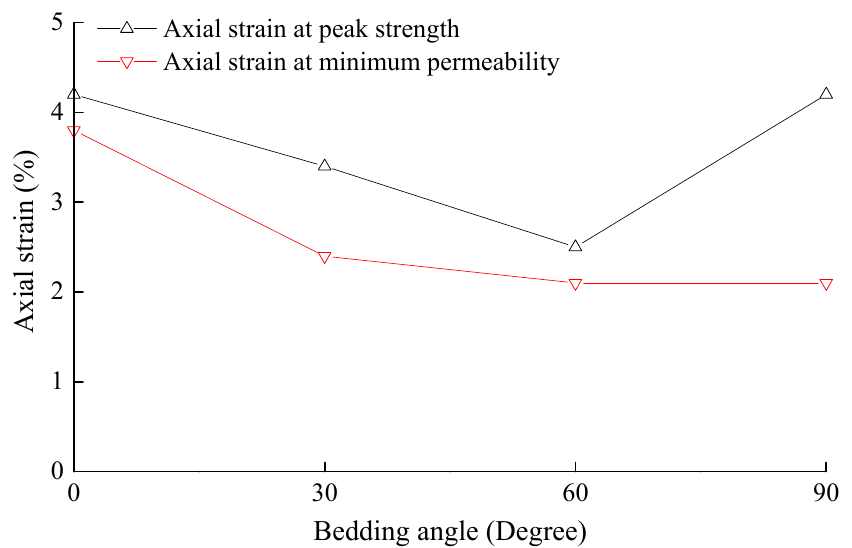
Figure 6. Axial strains at peak strength and minimum permeability at different bedding angles.